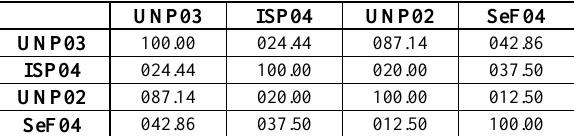
Table 3 Extract of the Jaccard index matrix